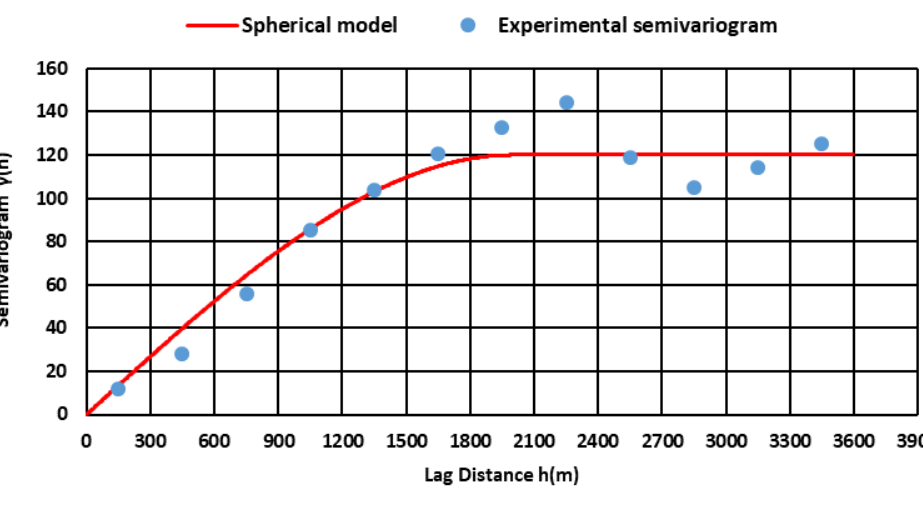
Figure 5: Experimental and theoretical semivariograms for the liquefaction potential